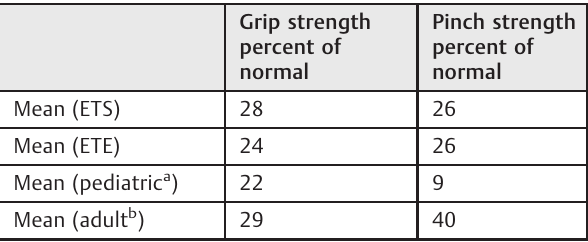
Table 3 Strati fi ed grip and pinch strength by nerve transfer type and patient